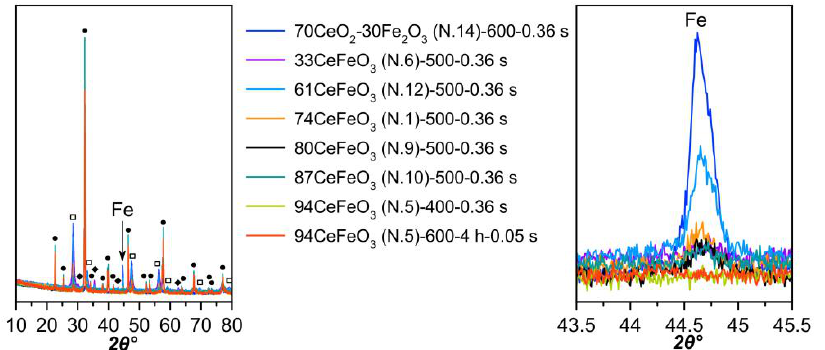
Figure 9. X-ray diffraction patterns of spent catalysts (the legend indicates the tested temperature, residence time, and T OS). ●– o-CeFeO 3 (JCPDS card no. 00-022- 0166); □– cubic CeO 2 (JCPDS card no. 01-075-8371); ◆ –γ -Fe 2 O 3 (JCPDS card no. 00-039-1346).